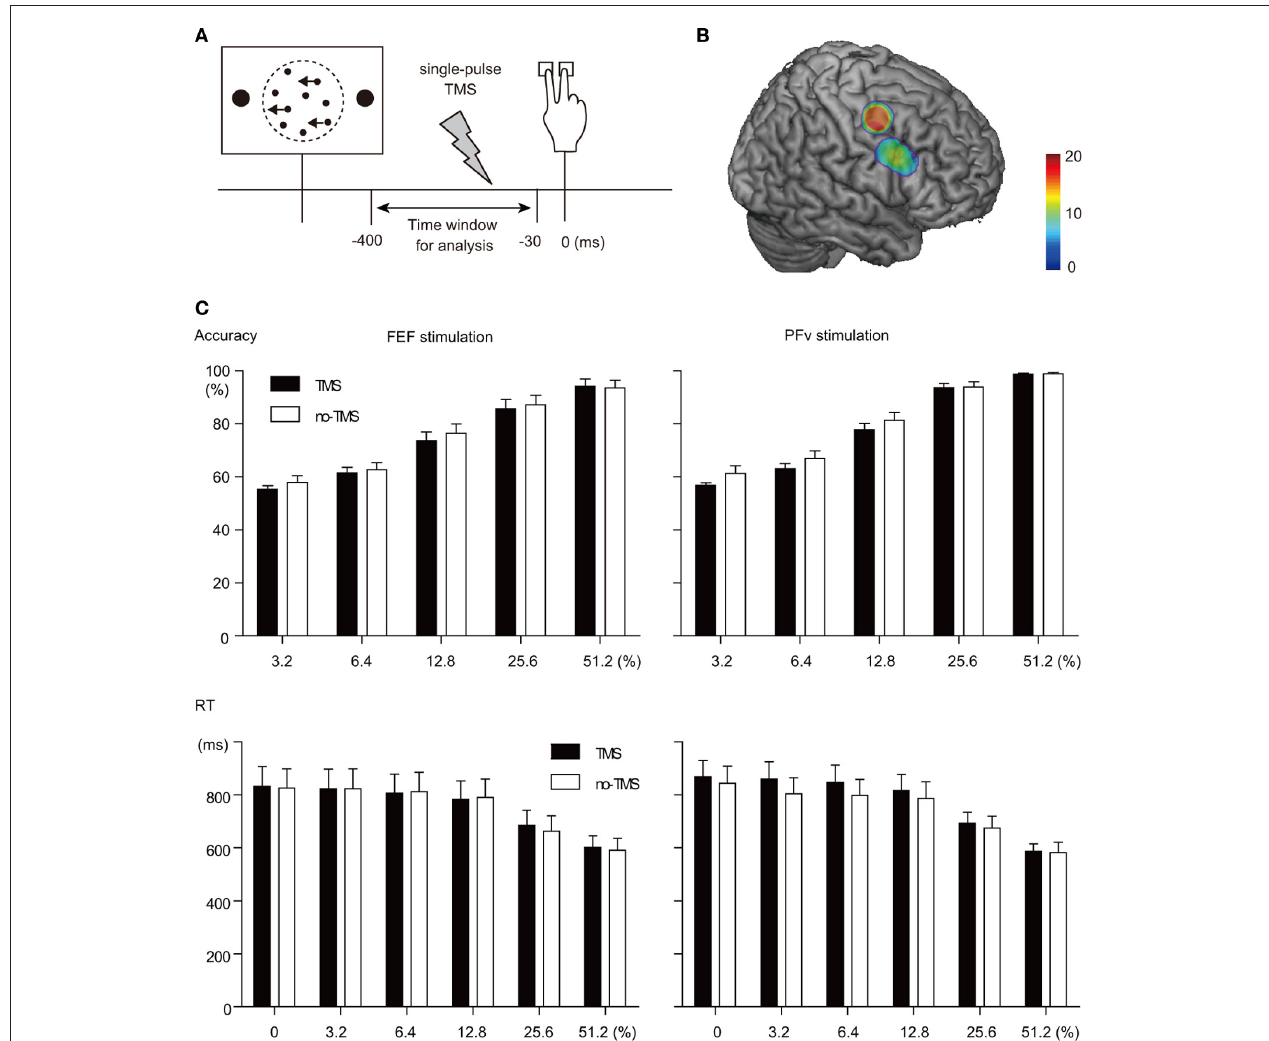
FIGURE 1 | TMS manipulation experiment. (A) Behavioral paradigm. A single-pulse TMS was given at variable timing between visual stimulus onset and behavioral response. Trials in which TMS was given within the time window between 30 and 400ms before behavioral response were analyzed. (B) Stimulation sites rendered on a template MNI brain. Dorsal and ventral clusters indicate FEF and